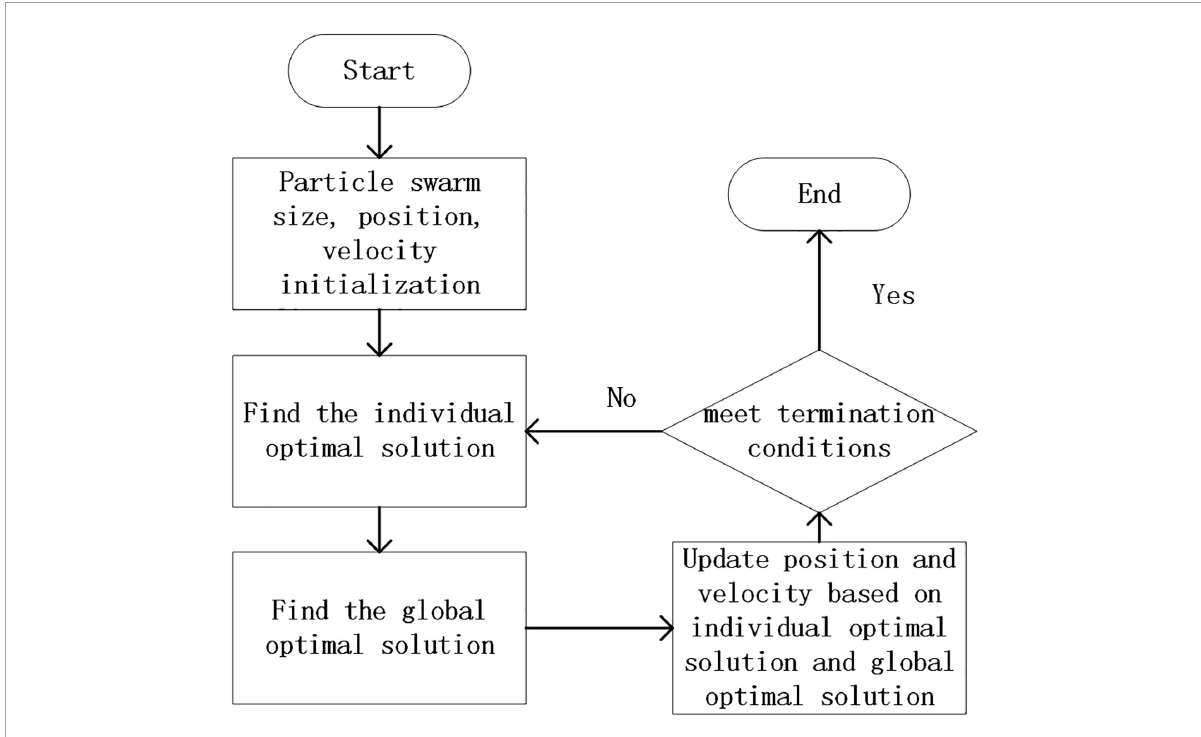
FIGURE2 Particle swarm optimization